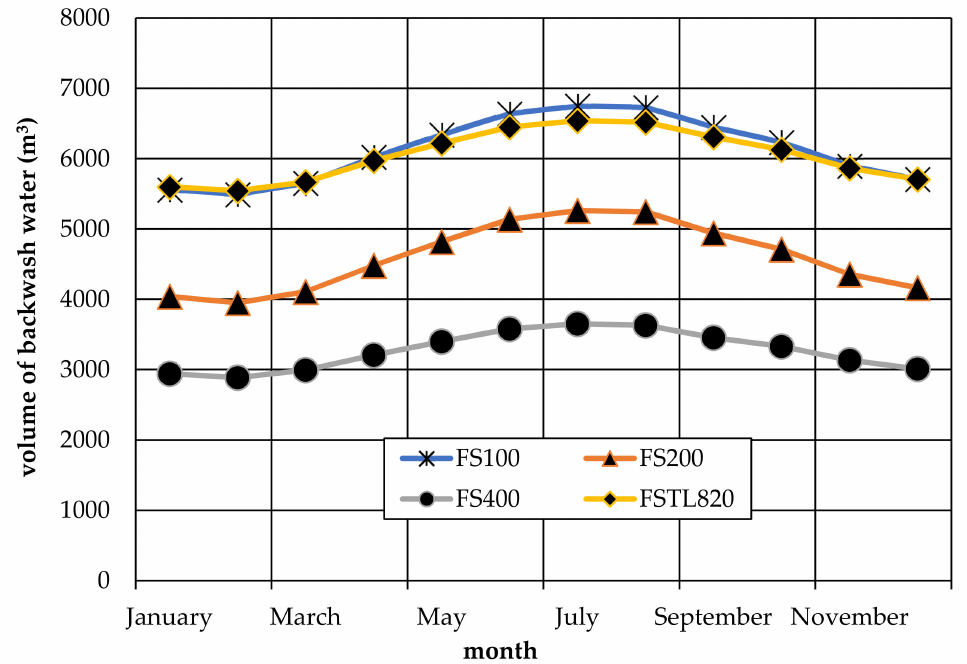
Figure 9. Volume of water used for backwashing 8 GAC filters at Rudawa River water reatment plant with monthly adjustment of backwash